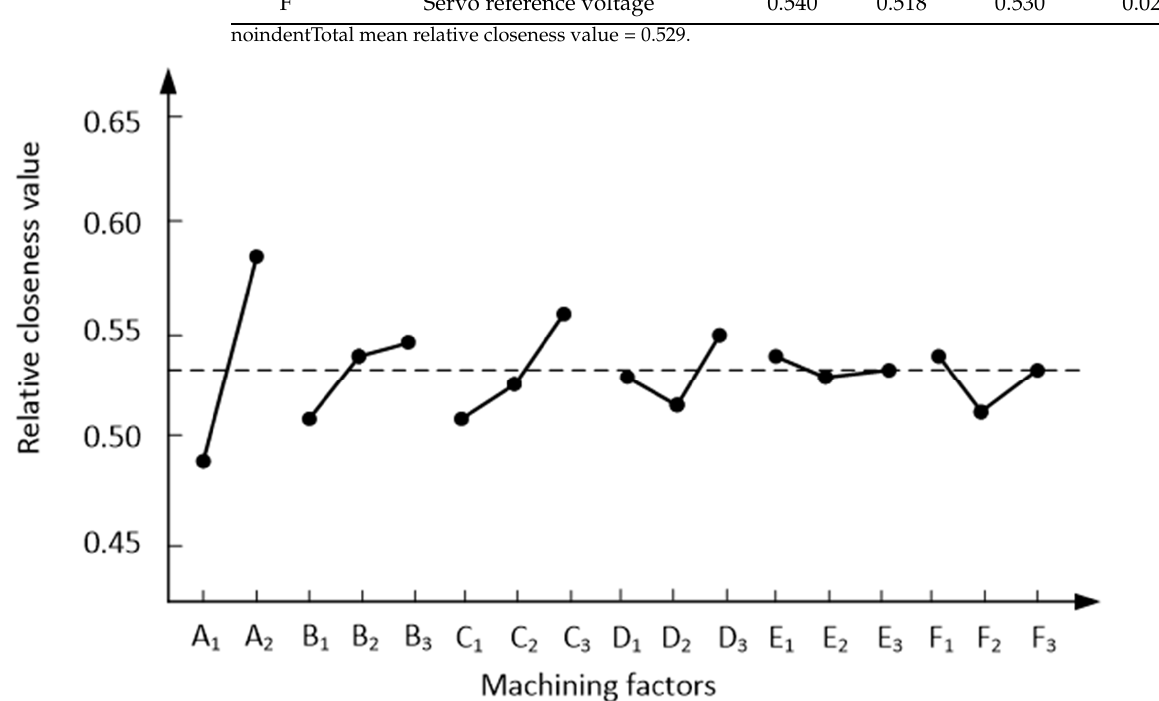
Figure 3. The relative closeness value graph.